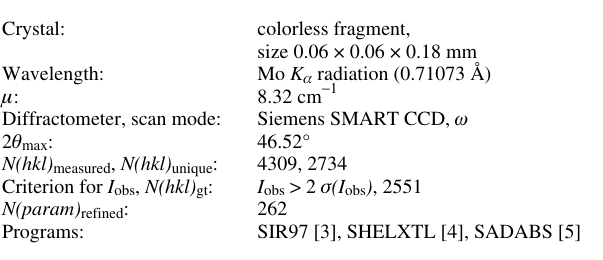
Table 4. Data collection and